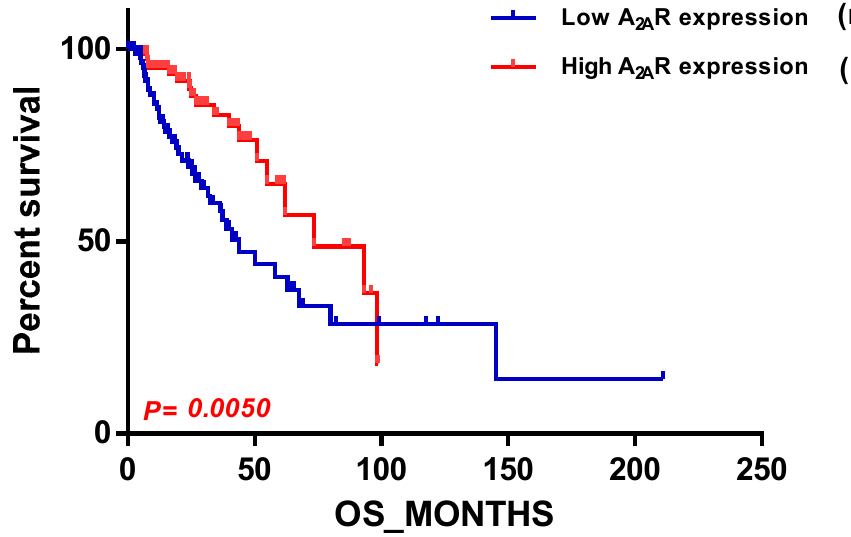
Figure 6. Survival curve according to A 2A R expression, indicating good prognosis survival in TCGA astrocytoma. Patients were divided into two groups based on median A 2A R expression. Blue curve represents patients with low expression, and red curve represents high A 2A R expression.